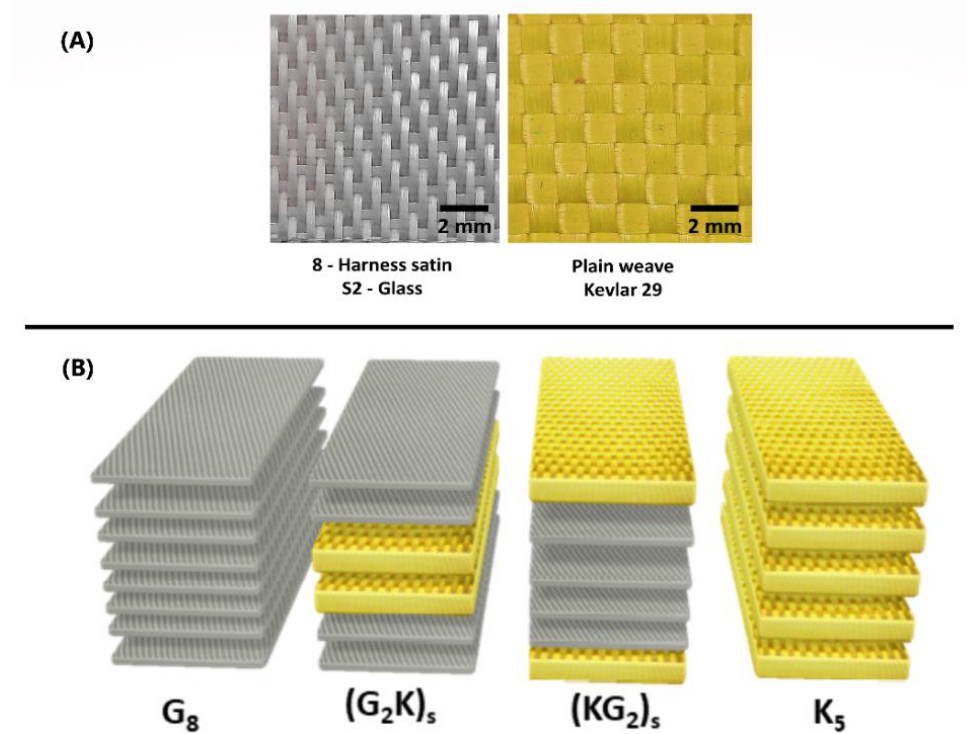
Figure 1. S2-glass and aramid (Kevlar 29 ® ) fabrics ( A ), stacking sequence and nomenclature adopted for the laminates (yellow for Kevlar 29 ® , grey for S2-glass) ( B ).